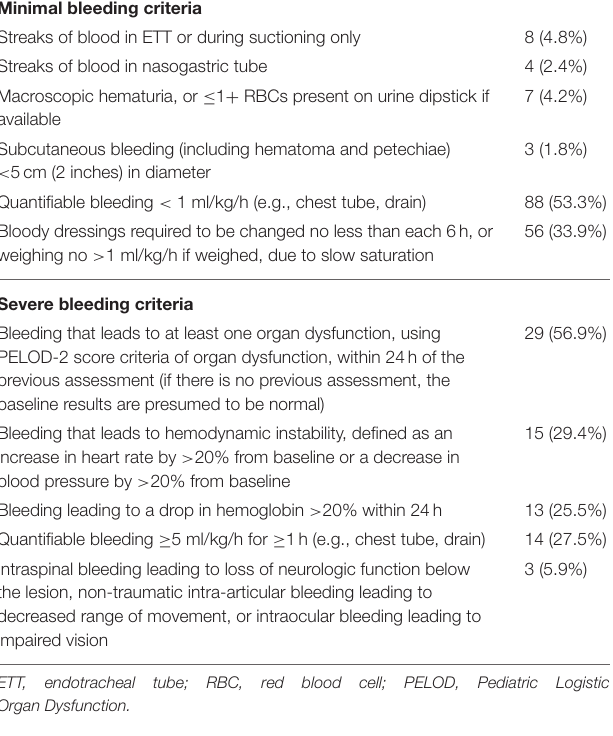
TABLE 2 | Criteria for minimal ( n = 165) and severe bleeding ( n = 51). Minimal bleeding criteria